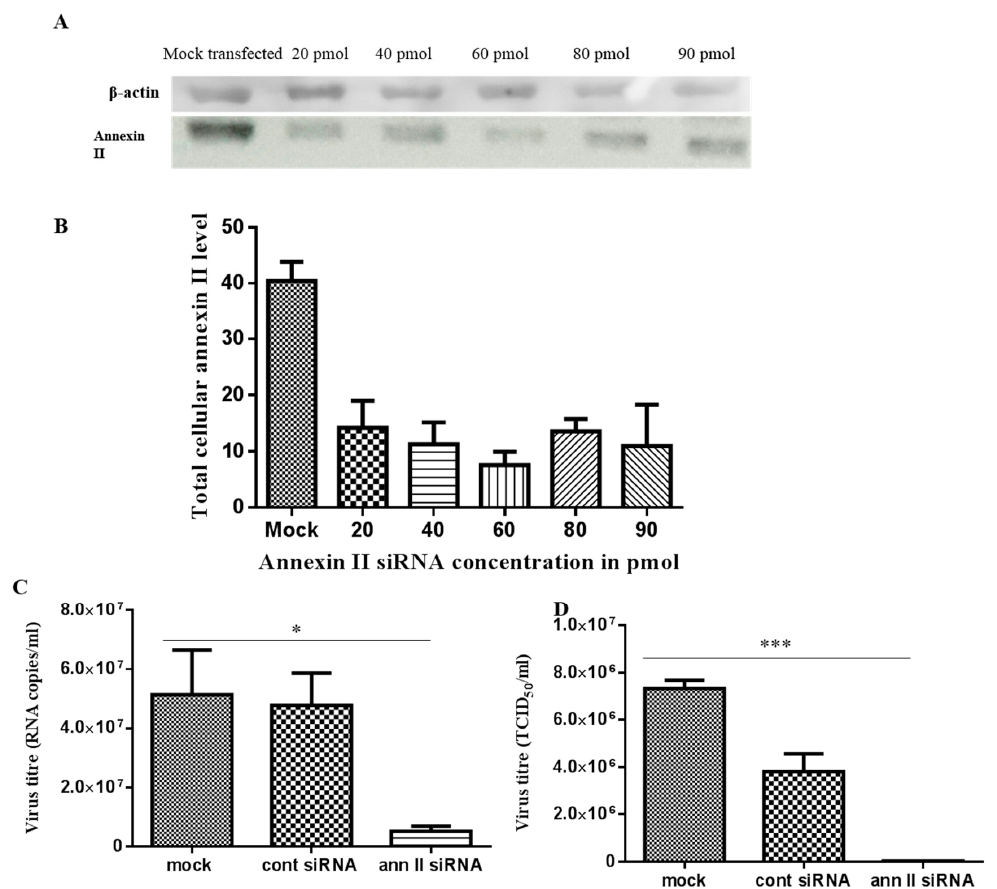
Figure 5. siRNA-mediated annexin II gene silencing and DENV2 infection on annexin II knockdown cells. Vero cells were either transfected with different concentrations of annexin II siRNA